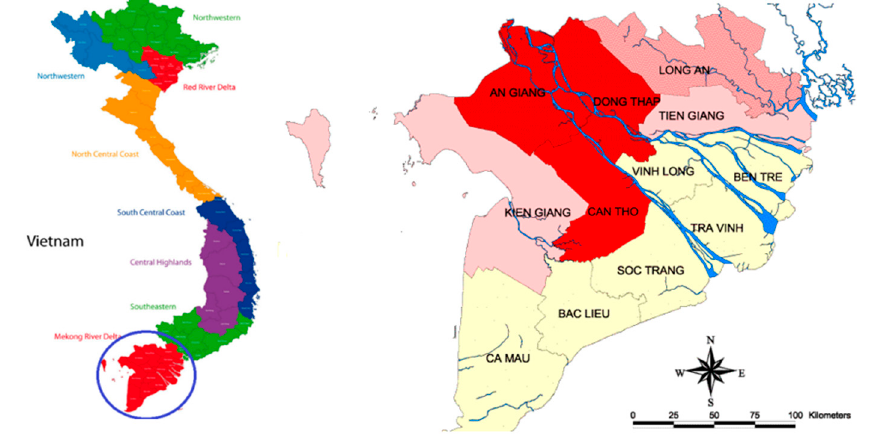
Figure 6. The geographical location of DMU. (Source: UN Development Programme.)